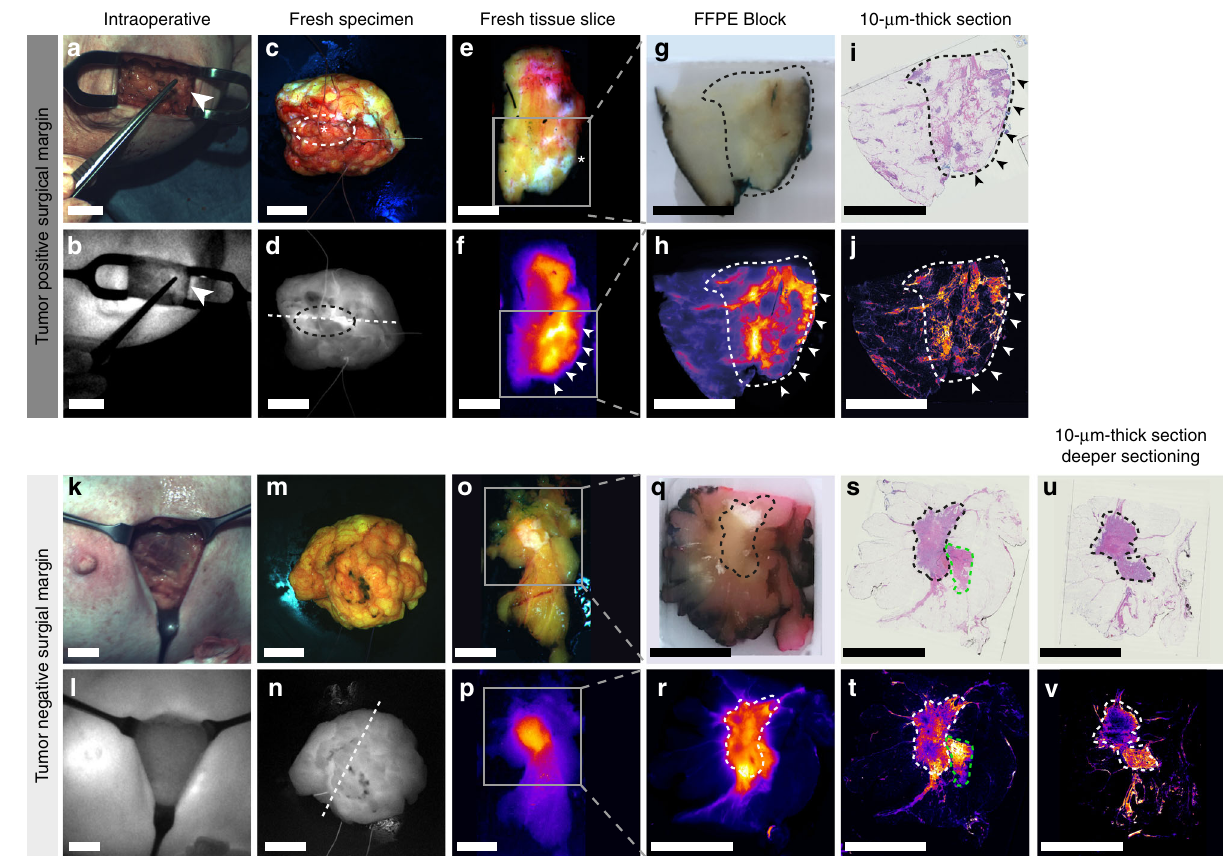
Fig. 5 Representative examples of intraoperatively detected tumor-involved surgical margin and a tumor negative surgical margin. Columns represent from left to right intraoperative imaging, fresh specimen imaging, fresh tissue slice imaging, FFPE block imaging, and imaging of 10- µ m-thick sections. The two upper rows represent a patient with a tumor-positive surgical margin, a clear fl uorescence signal was detected in the surgical cavity. Subsequently, the corresponding resection plane of the excised specimen was marked with an extra suture ( a , b ). Fluorescence imaging of the fresh surgical specimen showed high fl uorescence signals at the area of the suture mark ( c , d , asterisk). Corresponding fl uorescence images of fresh tissue slices, FFPE blocks and 10- µ m-thick sections showed high fl uorescence signals at the margin ( e – j , arrows). Histopathology con fi rmed the presence of tumor deposits in this area ( i ). The lower rows represent a patient with a tumor-free surgical margin Fig. 5 k – t . Deeper sectioning of the FFPE block ( q , r ) was performed to investigate the probable cause of the high fl uorescent area within the green dashed line ( t ). u , v Arrow depicts the surgical positive margin. Dashed white/black circle indicates the area with the highest fl uorescence signal intensities. The asterisk represents the position of the extra suture mark. The gray box represents the origin of the FFPE block in the fresh tissue slice. The dashed white/black line delineates tumor tissue. The dashed green line delineates collagen tissue with normal parenchyma. Scale bars represent 1